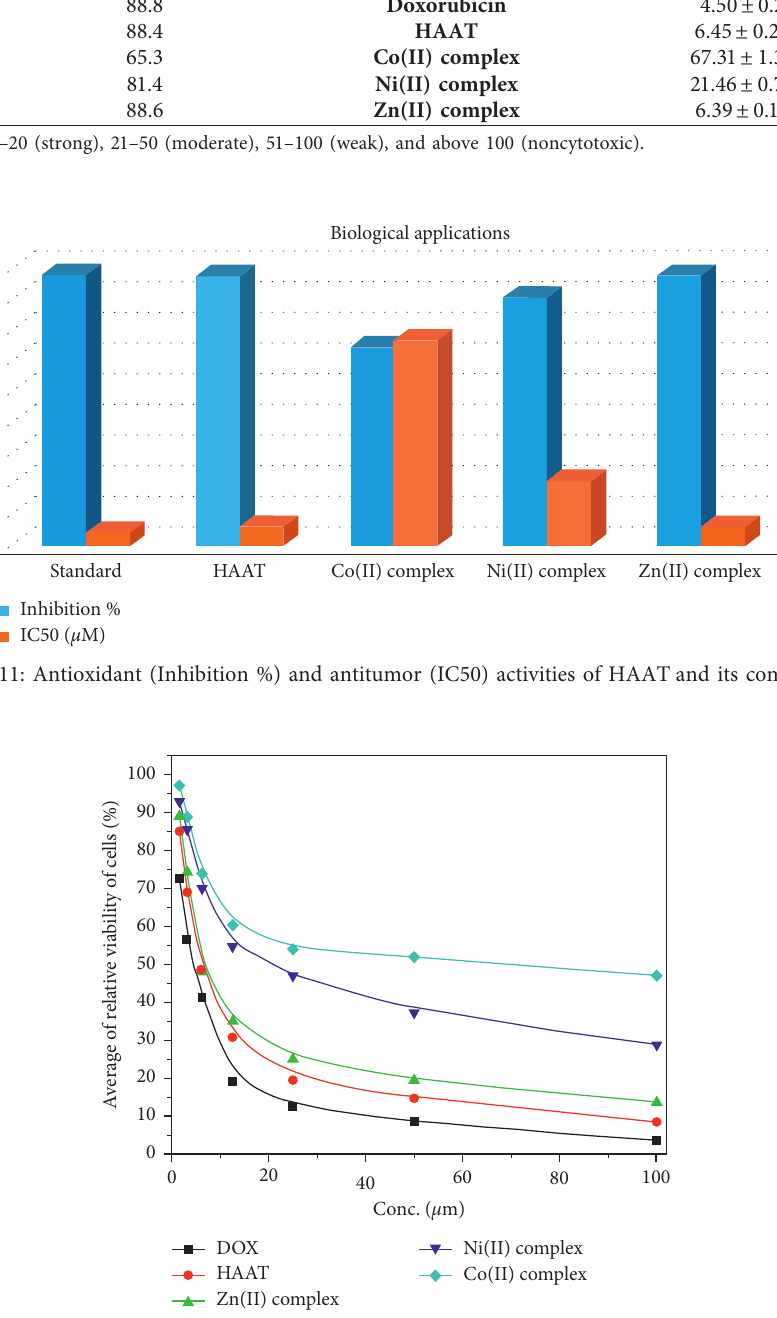
Figure 12: In vitro cytotoxic activities of HAAT and its complexes compared with the standard doxorubicin against HepG2cell